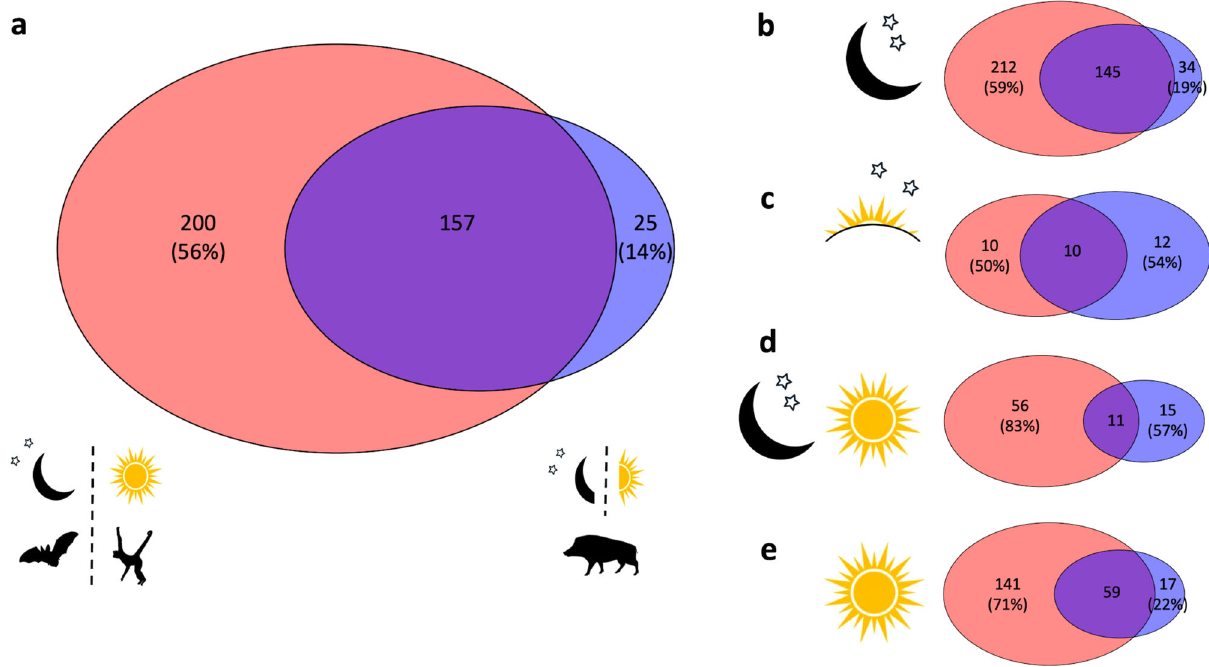
Fig. 3 Diel fl exibility in functional trait space. Hypervolumes were constructed of diel obligate (red) and diel fl exible (blue) species, before assessing comparative statistics across a all species, b nocturnal species only (moon and stars silhouette), c crepuscular species only (sunset/sunrise and stars image), d cathemeral species only (moon, stars and sun image) and e diurnal species only (sun image). Numbers give the volume of the unique diel obligate hypervolume (red), the unique diel fl exible hypervolume (blue) and the overlapping volume between hypervolumes (purple; Supplementary Table 3). The percentage of the hypervolume that is unique to obligate and fl exible species is given in parentheses. Mammal silhouettes give examples of diel obligate and diel fl exible species and were freely downloaded from PhyloPic www.phylopic.org, under CC0 1.0 Public Domain